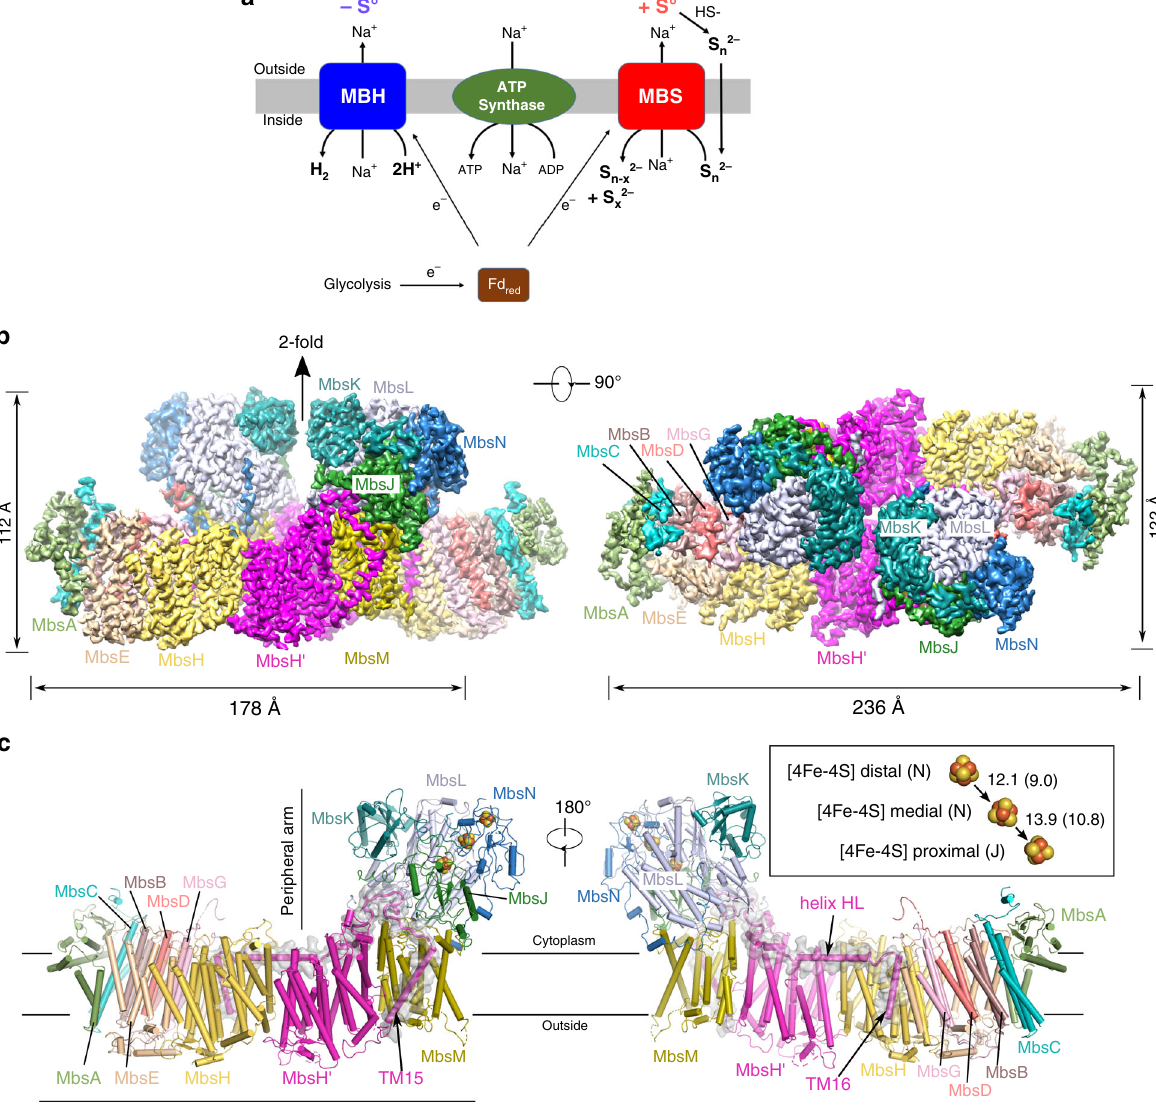
Fig. 1 Overall structure of the P. furiosus MBS complex. a Schematic comparison of P. furiosus MBH and MBS complexes, both generating a Na + gradient for ATP synthesis. b Side (left) and top (right) views of the cryo-EM map of the dimeric MBS complex, segmented and colored by subunits. c The front (left) and back (right) view of the atomic model of an MBS monomeric complex. Individual subunits are colored as in ( b ). Inset in the right panel: a chain of three [4Fe-4S] clusters in the peripheral arm, with the center-to-center and edge-to-edge distances (in brackets) between metal sites indicated in